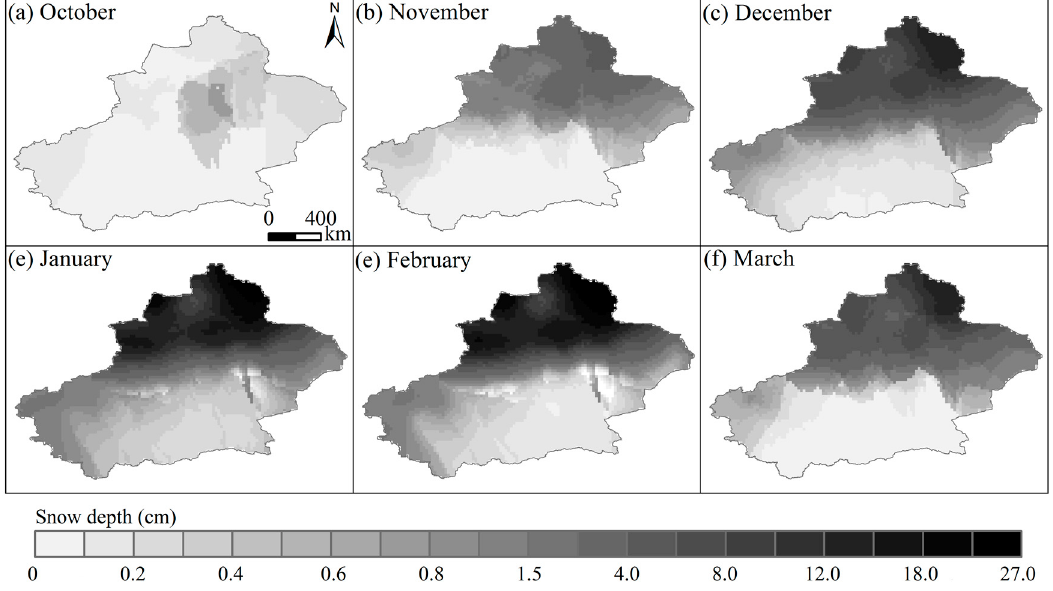
Figure 3. Spatial variation of monthly snow depth (cm) over 1961–2015 in Xinjiang: ( a ) October, ( b ) November, ( c ) December, ( d ) January, ( e ) February and ( f ) March.